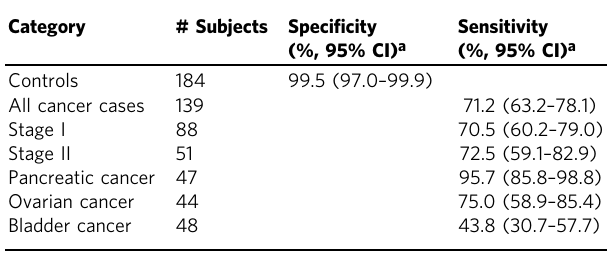
Table 1 Performance of logistic classi fi er using EV